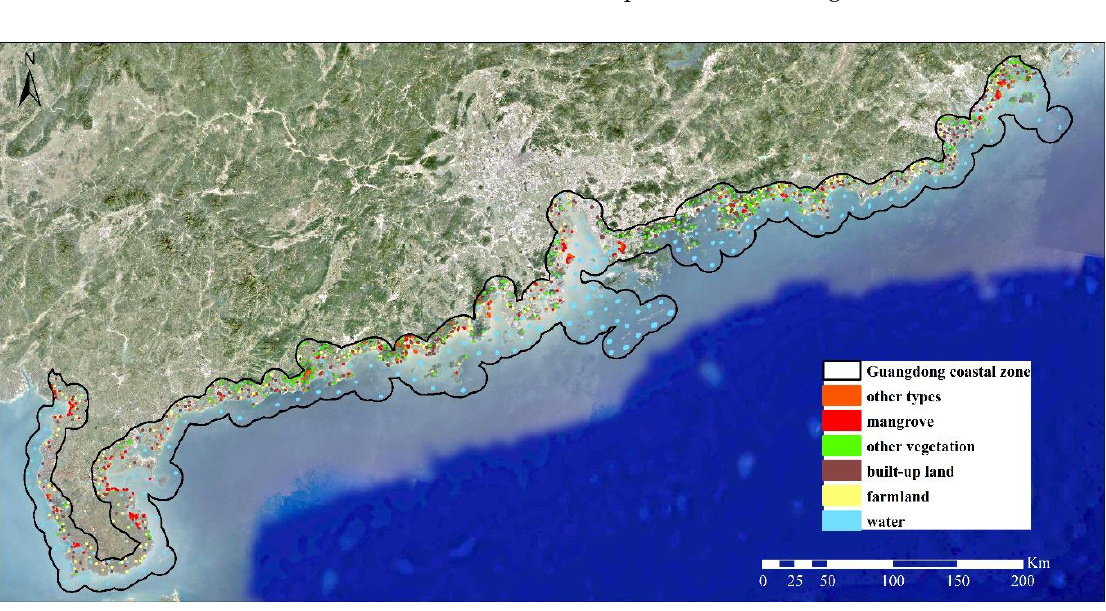
Figure 3. Spatial distribution of validation samples in